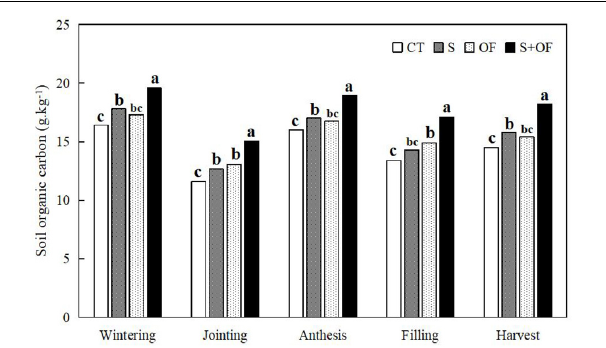
FIGURE 2 | Effects of subsoiling, organic fertilizer and subsoiling combined with organic fertilizer on soil organic carbon at different growth stages of winter wheat in 2019. CT, conventional tillage; S, subsoiling; OF, organic fertilizer; S+OF, organic fertilizer combined with subsoiling. Different lowercase letters in the same growth stage indicate significant differences among treatments by LSD test ( P < 0.05).